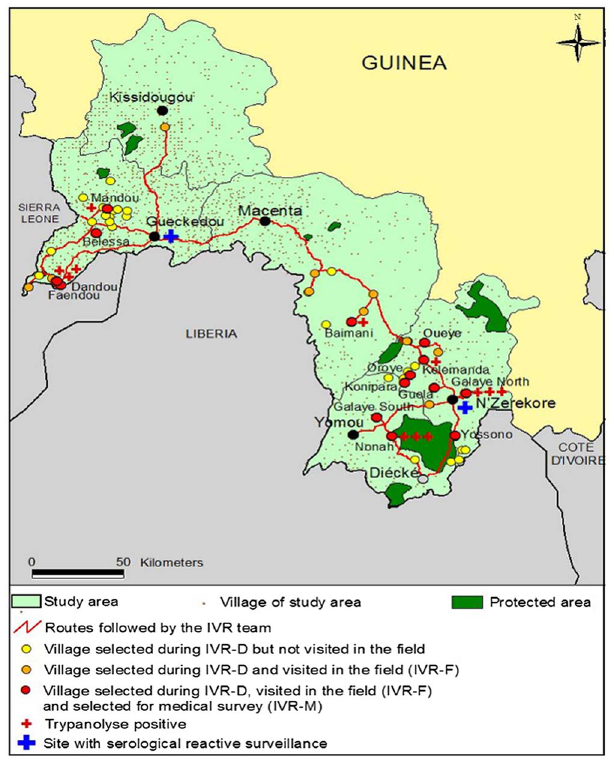
Figure 5. Villages identi fi ed during the IVR-D step, villages visited in the fi eld (IVR-F), and villages selected for the active screening (IVR-M). The map displays the 49 villages selected during the IVR-D step, and the itinerary followed by the IVR team in the fi eld to visit 24 of the villages. Fourteen of these villages were selected for the active screening, which are primarily located in the Gueckedou and N ’ Zerekore